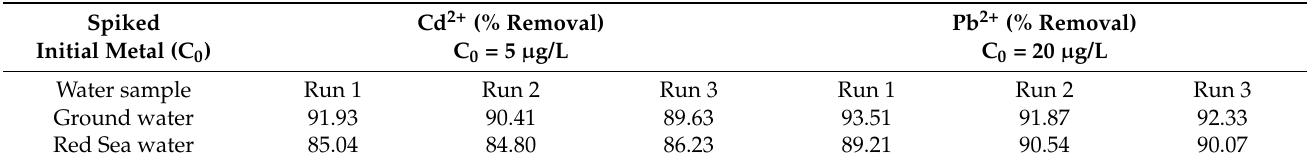
Table 8. Cd 2+ and Pb 2+ removal % from environmental samples using green-synthesized